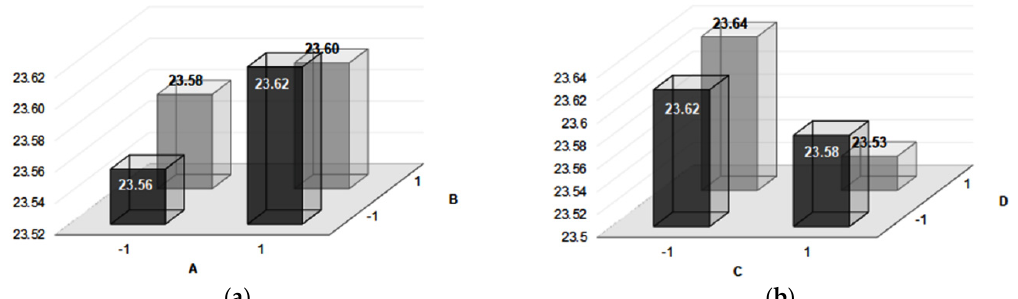
Figure 2. Representation of the standardized effects for the weight percentages of the different phases plotted on a normal probability graph. Factors with a significant effect have been labelled. A(destabilisation temperature); B(cooling media); C(tempering temperature); D(tempering time): ( a ) wt.% austenite; ( b ) wt.% tempered martensite; ( c ) cell volume of tem ‐ pered martensite; ( d ) wt.% carbides M 7 C 3 (K 2 ); ( e ) wt.% carbides M 2 C.